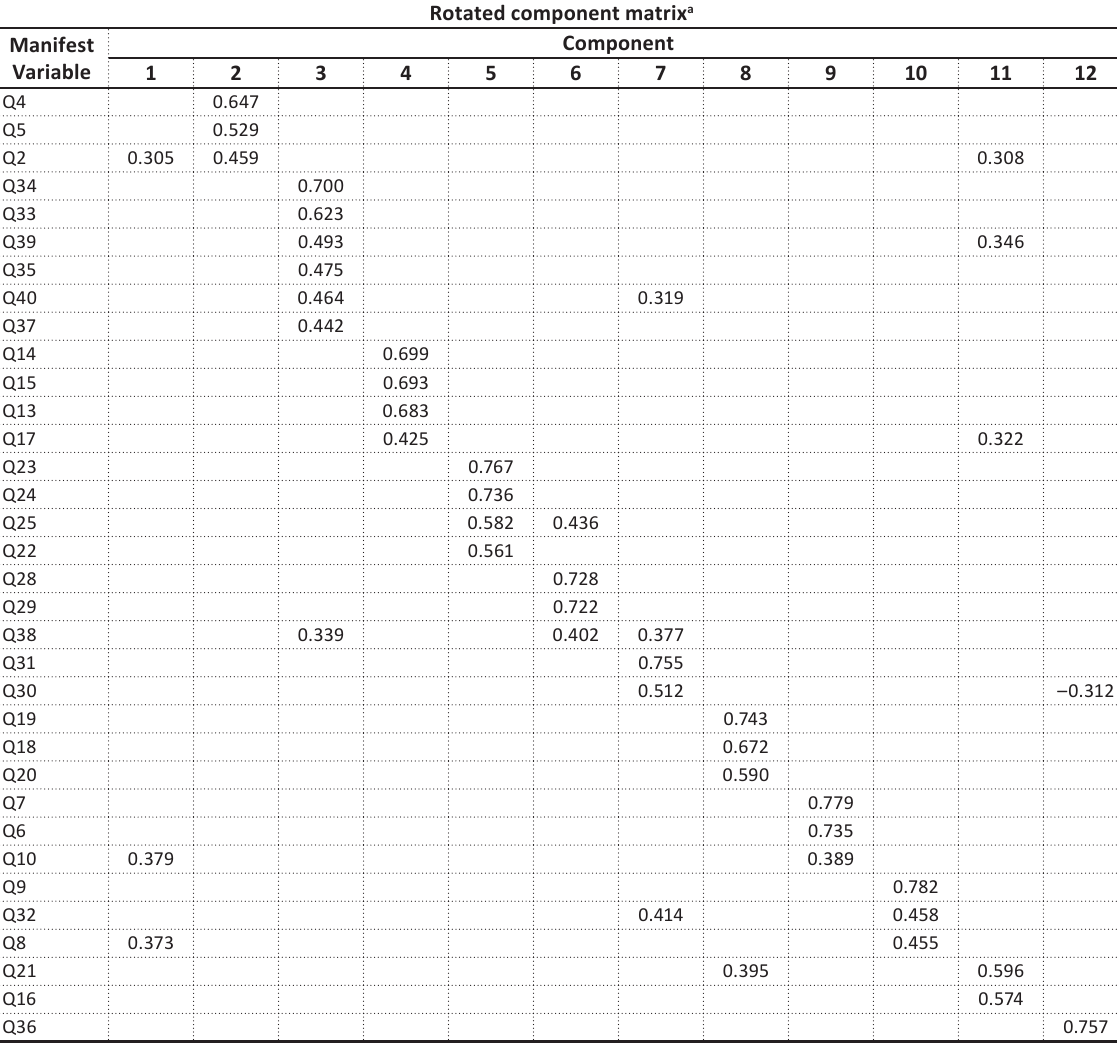
Table 3 (cont.). Rotated component